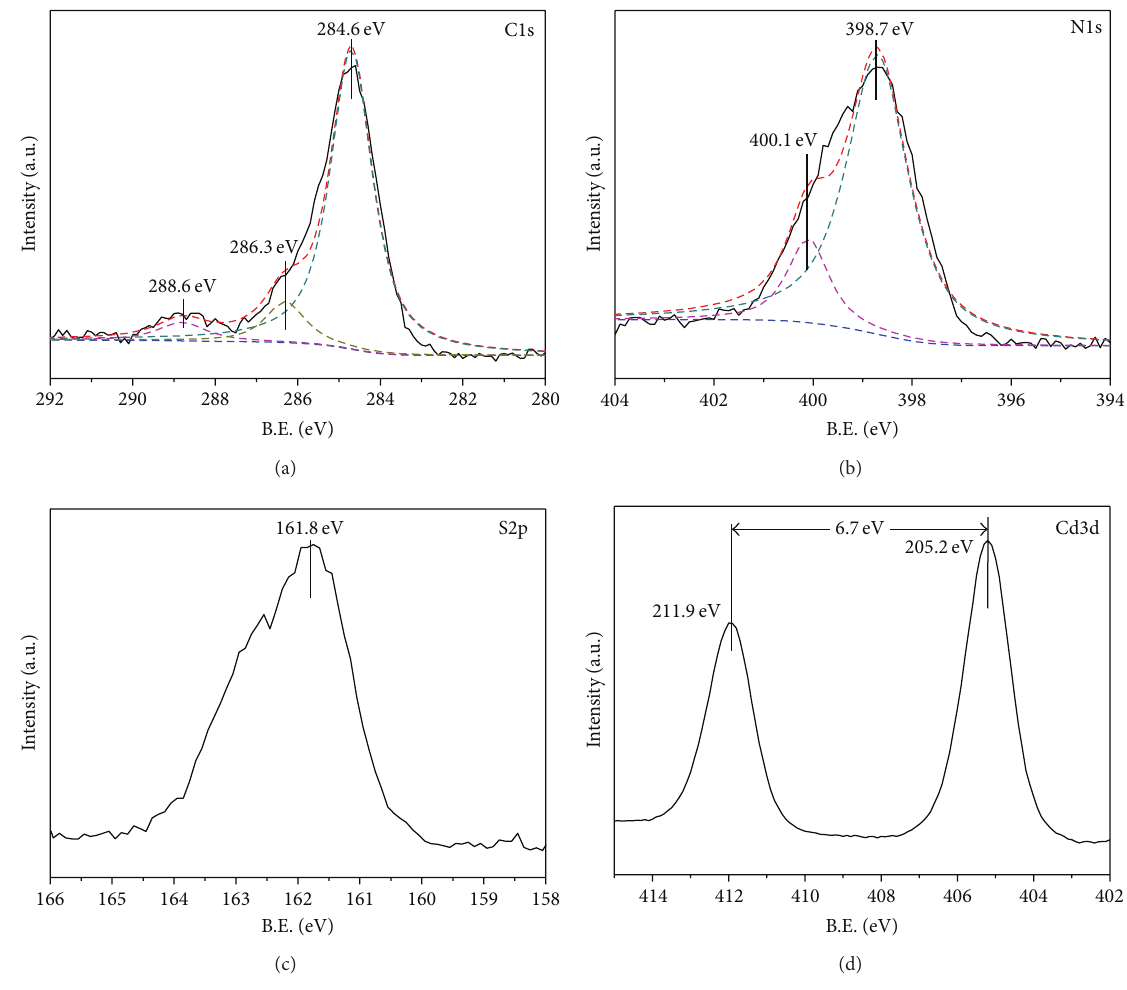
Figure 3: XPS spectra of the as-obtained sample CdS/CN-10: (a) C1s; (b) N1s; (c) S2p; (d) Cd3d.